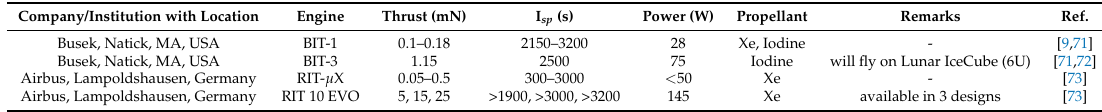
Table 5. Summary of RF Ion Propulsion